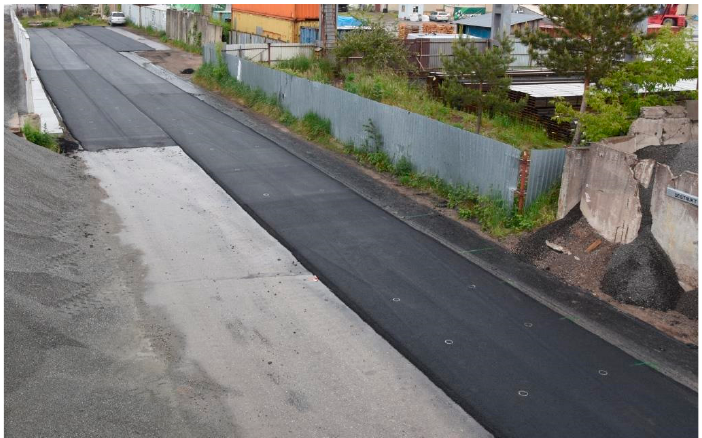
Figure 11. Second short test section located at the asphalt plant (MTM2)–June 2020.